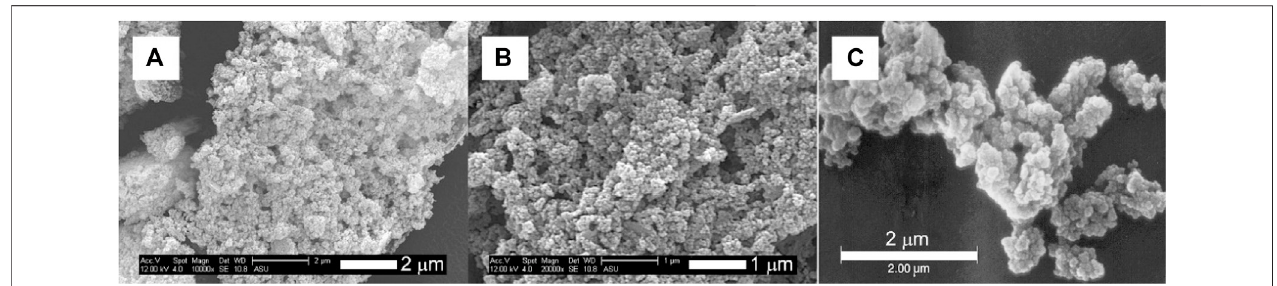
FIGURE 5 | SEM micrographs of DGP-A (A, B) , and commercial aluminosilicate, Hydrex ® (C) , modi fi ed from Laine. (Laine)